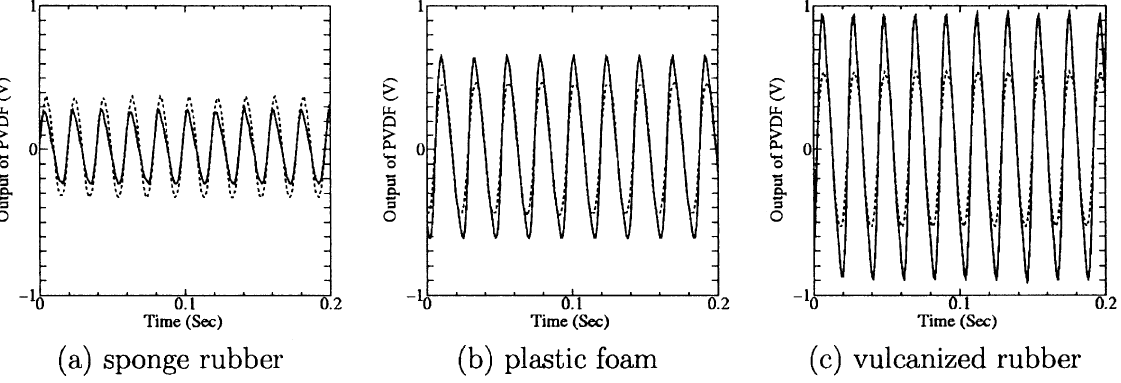
Fig. 12. Voltate output histories of Fig. 11(b). (—) PVDF1, (- - - ) PVDF2.